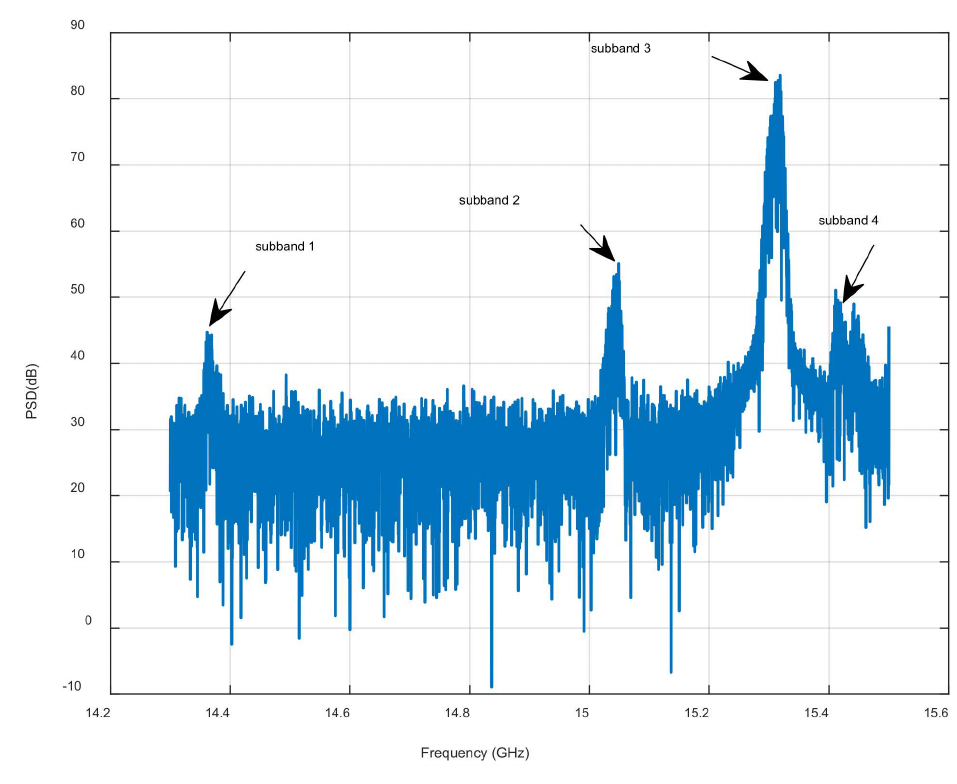
Figure 16. Acquired spectrum of the Starlink